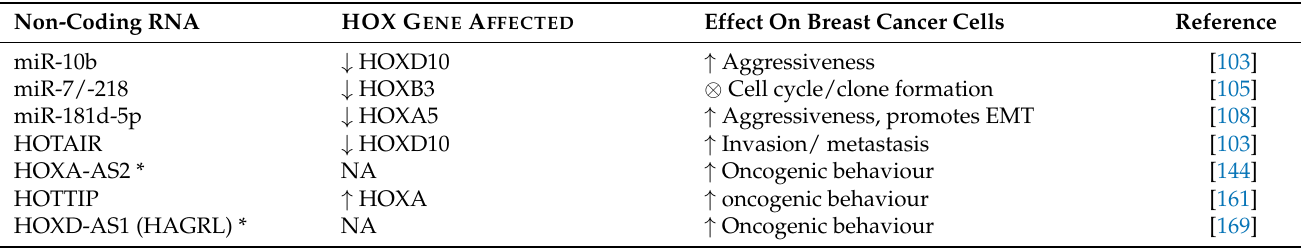
⊗ , Inhibition; ↑ , Increase; ↓ , Decrease; *, Noncoding RNAs transcribed from HOX genes loci; NA, Not